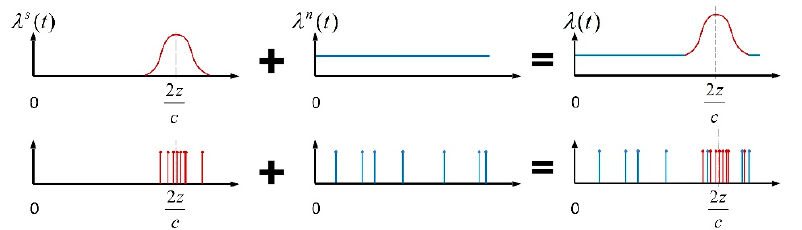
Figure 1. Signal and noise Poisson model, λ s ( t ) , λ n ( t ) and λ ( t ) are signal rate, noise rate and total rate respectively, Z is depth and c is velocity of